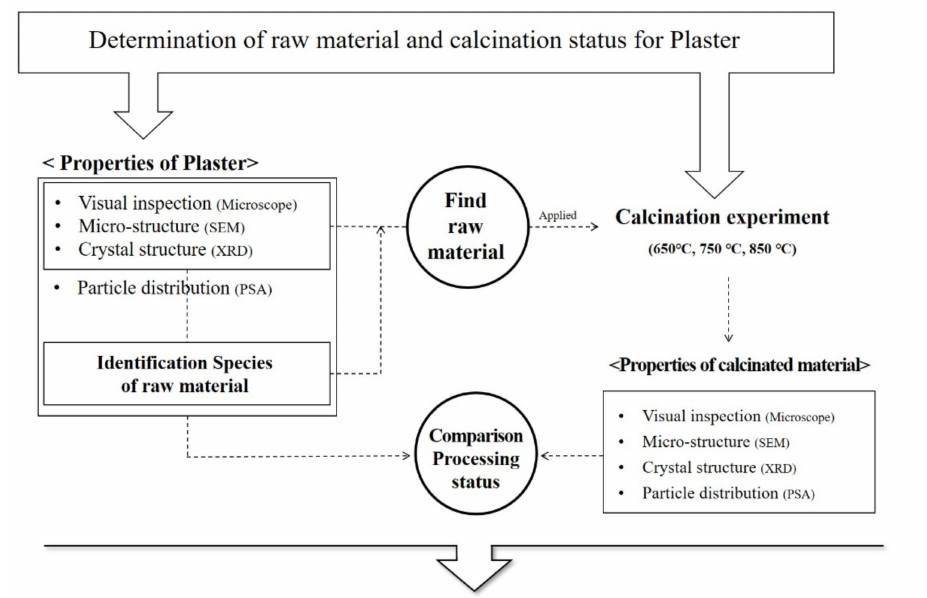
Figure 2. Flowchart of a research process for discovering wall manufacturing